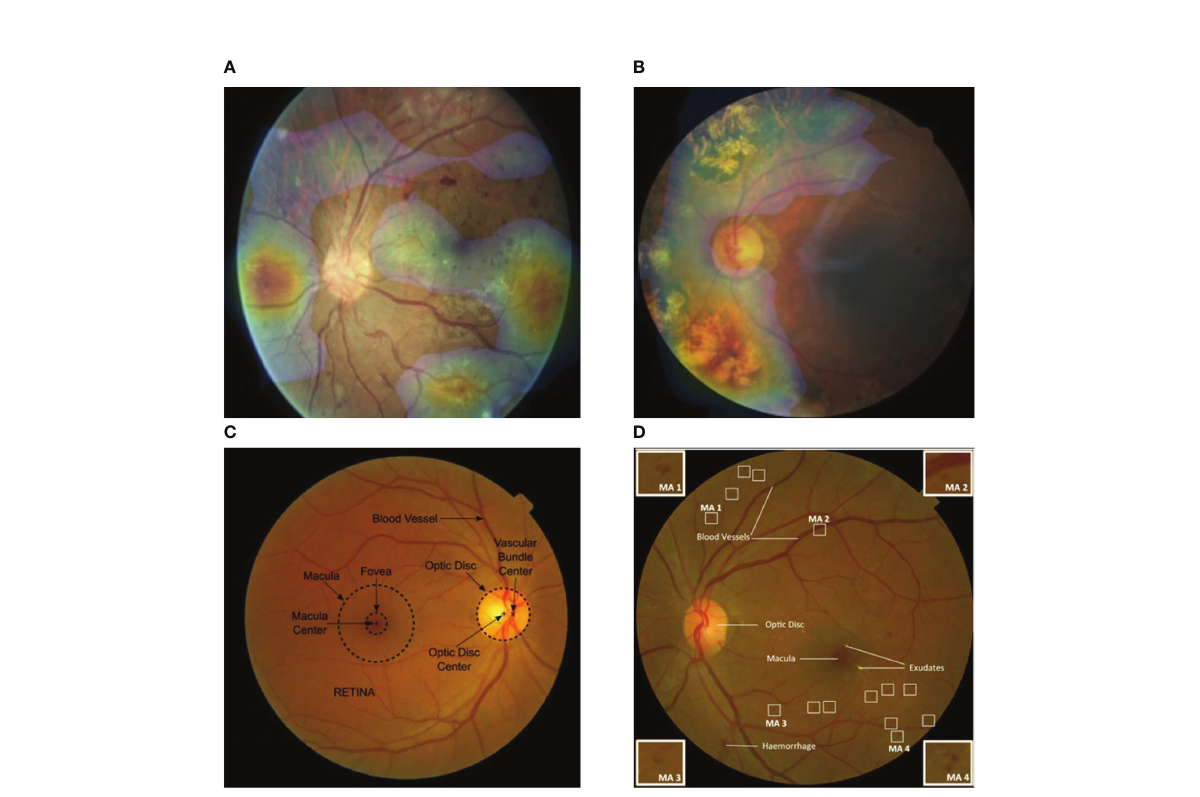
FIGURE 2 Visualization features generated automatically from color fundus photography. (A) Fundus heat map overlaid on a fundus image, pathologic regions of interest are in temporal and nasal quadrants as shown. (B) Pathologic fi ndings are distributed in lower and upper-left quadrants as highlighted. (C) General anatomic landmarks for orientation in retina are labeled automatically. (D) Relevant pathologic structures: hemorrhage, exudates, and microaneurysms are shown. Image patches at four corners display the representative features of microaneurysm changes detected by arti fi cial intelligence (AI) [Adapted from Ursula Schmidt-Erfurth et al.